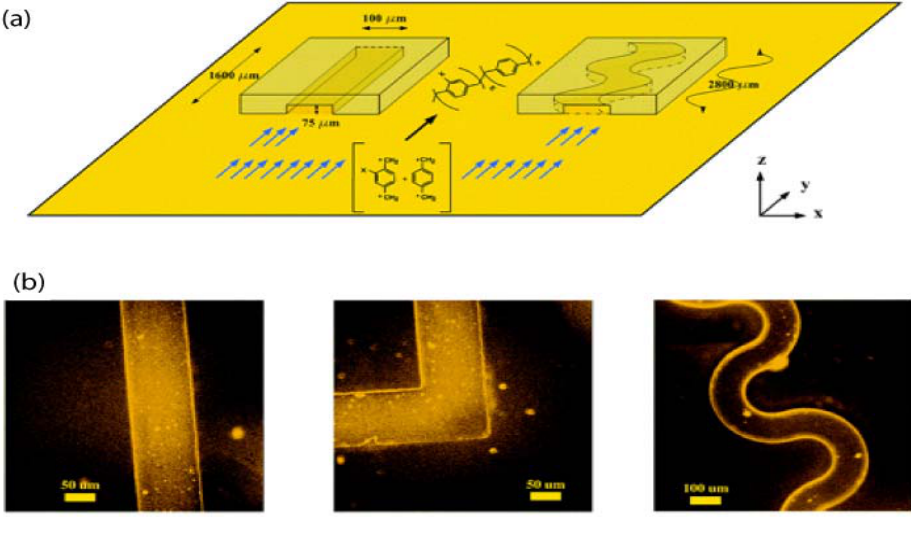
Figure 15. (a) CVD polymerisation within confined geometries of straight and meandering channels. (b) Fluorescence micrographs of sealed devices coated with parylene